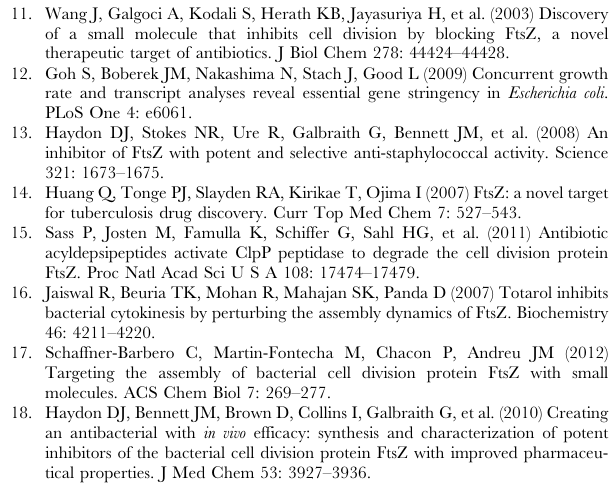
Figure S1 ss count plot. The ss count plot is the propensity of a base to be single stranded as determined by the number of times it is single stranded in a group of predicted foldings, in this case 33, (http://mfold.rna.albany.edu/?q = mfold/documentation). To simplify the interpretation, the length of the untranslated region (black bar) and the coding region of ftsZ (arrow) has been superimposed to the plot. (ZIP)